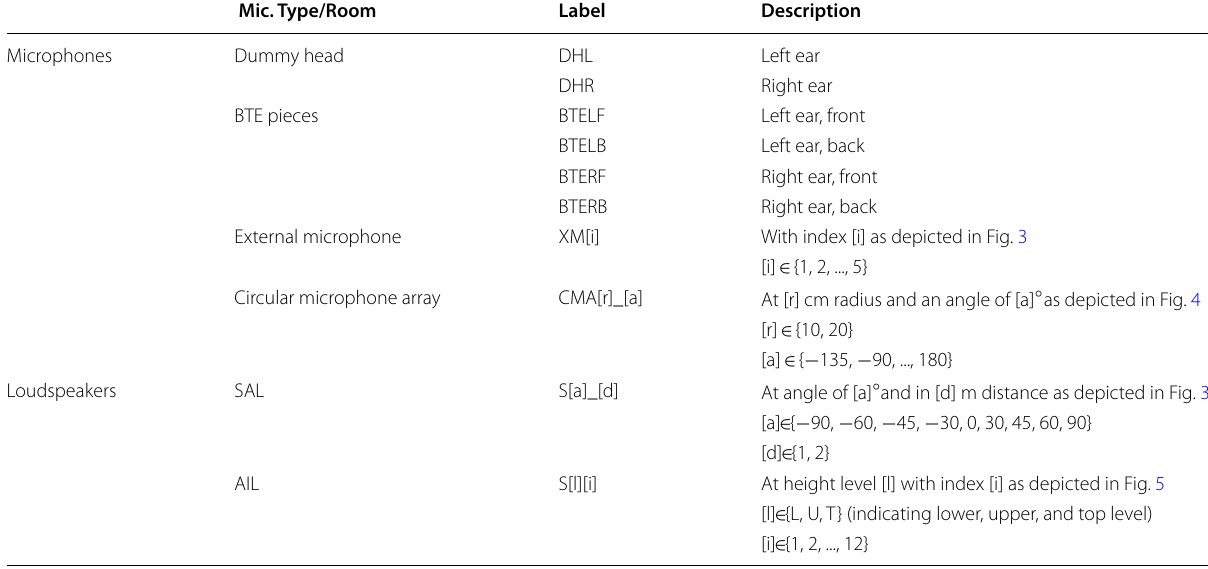
Table 2 Microphone and loudspeaker